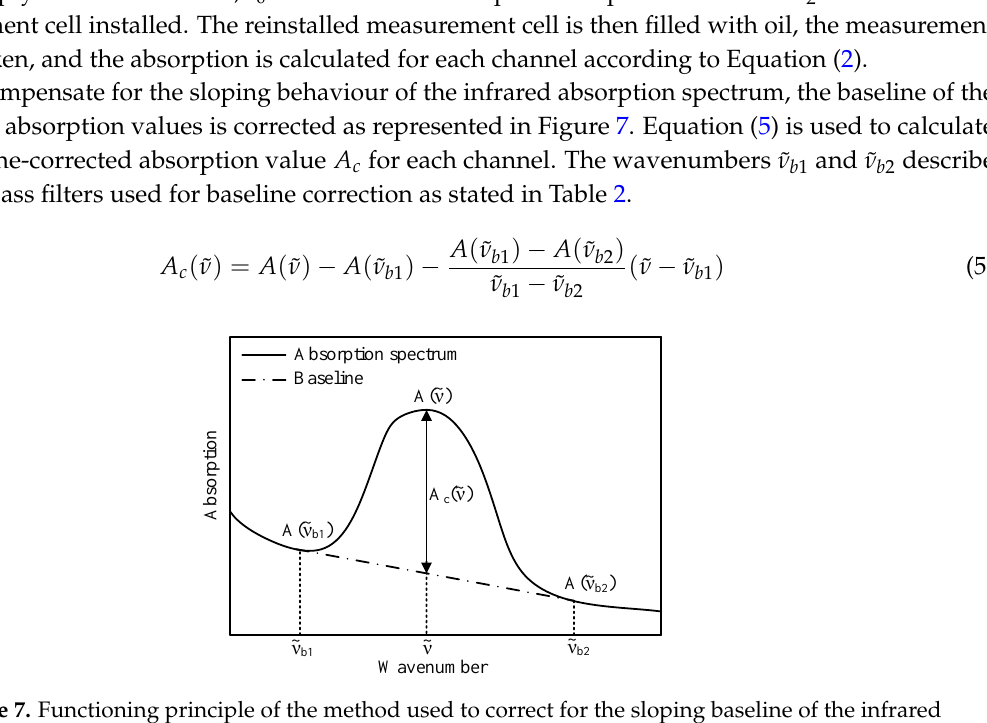
Figure 7. Functioning principle of the method used to correct for the sloping baseline of the infrared absorption